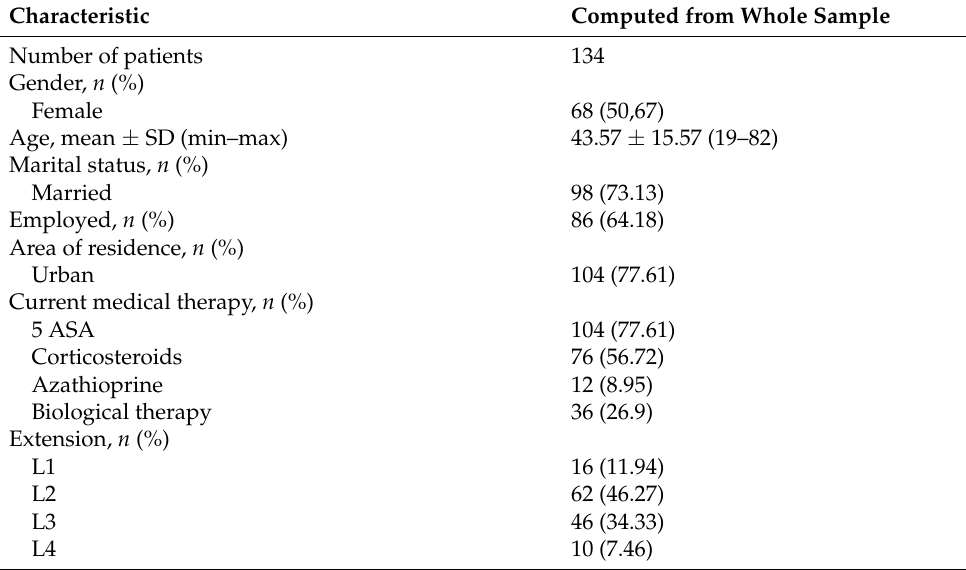
Table 1. Clinical and demographic characteristics of participants included in